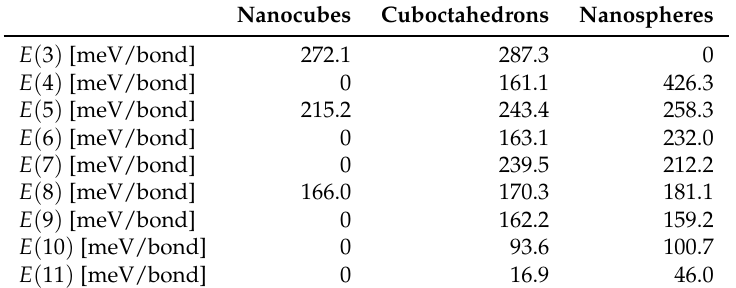
Table 2. Fitted coefficients E ( i ) for the excess energy expression according to Equation (10). The index i expresses the coordination of atoms (i.e., (12 i ) is the number of broken bonds, −